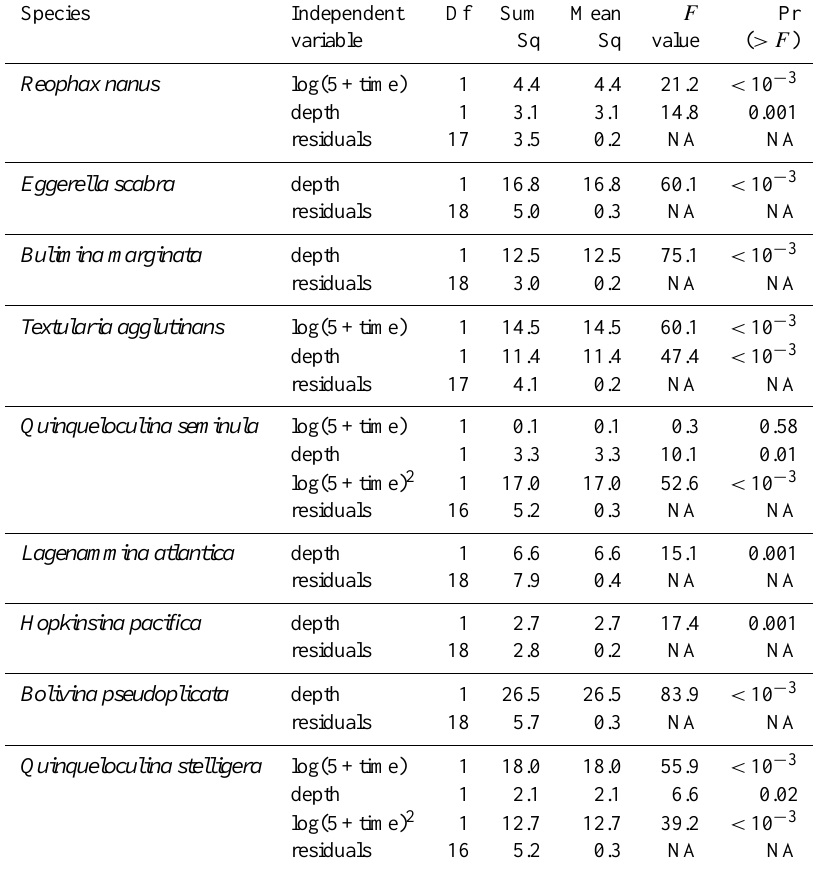
Table 4. Statistical parameters (Df: degrees of freedom; Sum Sq: sum of squares; Mean Sq: mean of squares; F value: value of the F test; Pr ( >F ): probability of the F test) for the model-type 2 for all the nine major species and for the standing stock. Species Independent Df Sum